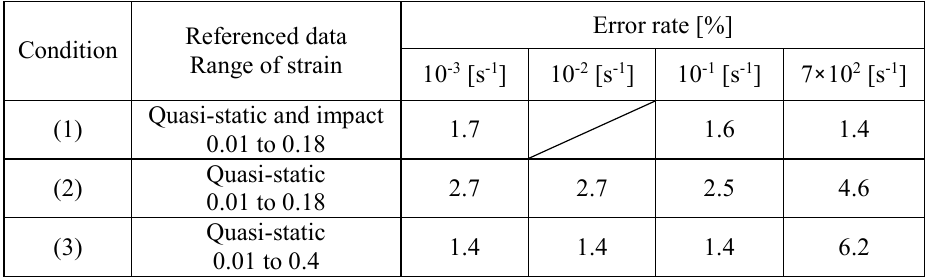
Table 2. Error rate between experimental results and CS